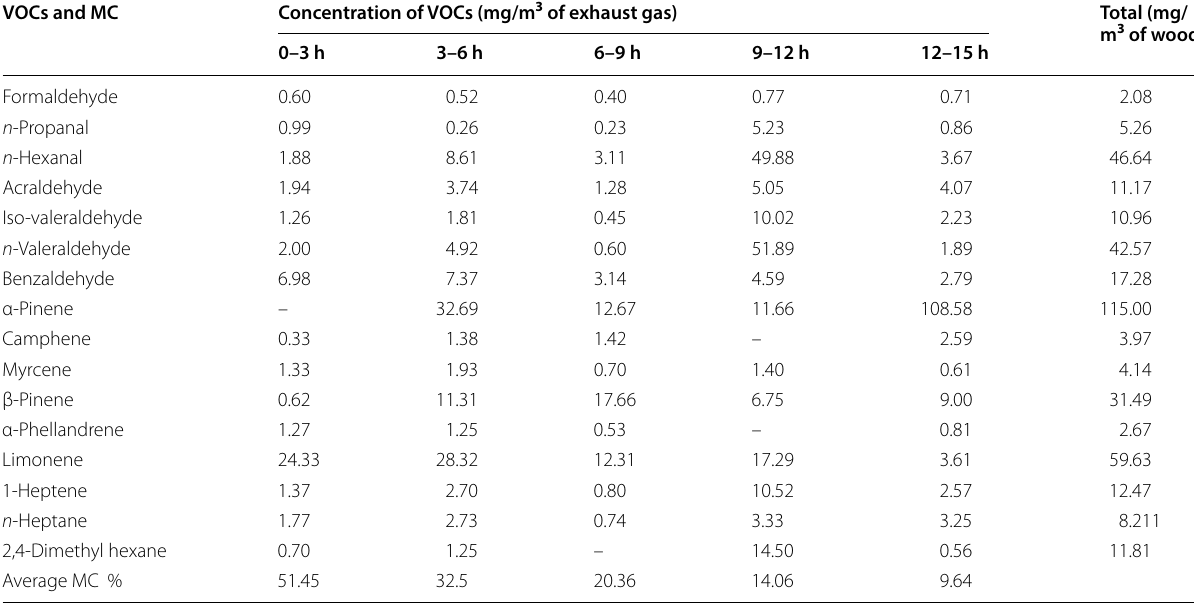
Table 5 Constituents and amount of VOCs released during each period of high-temperature drying (Russian Pinus sylvestris ) VOCs and